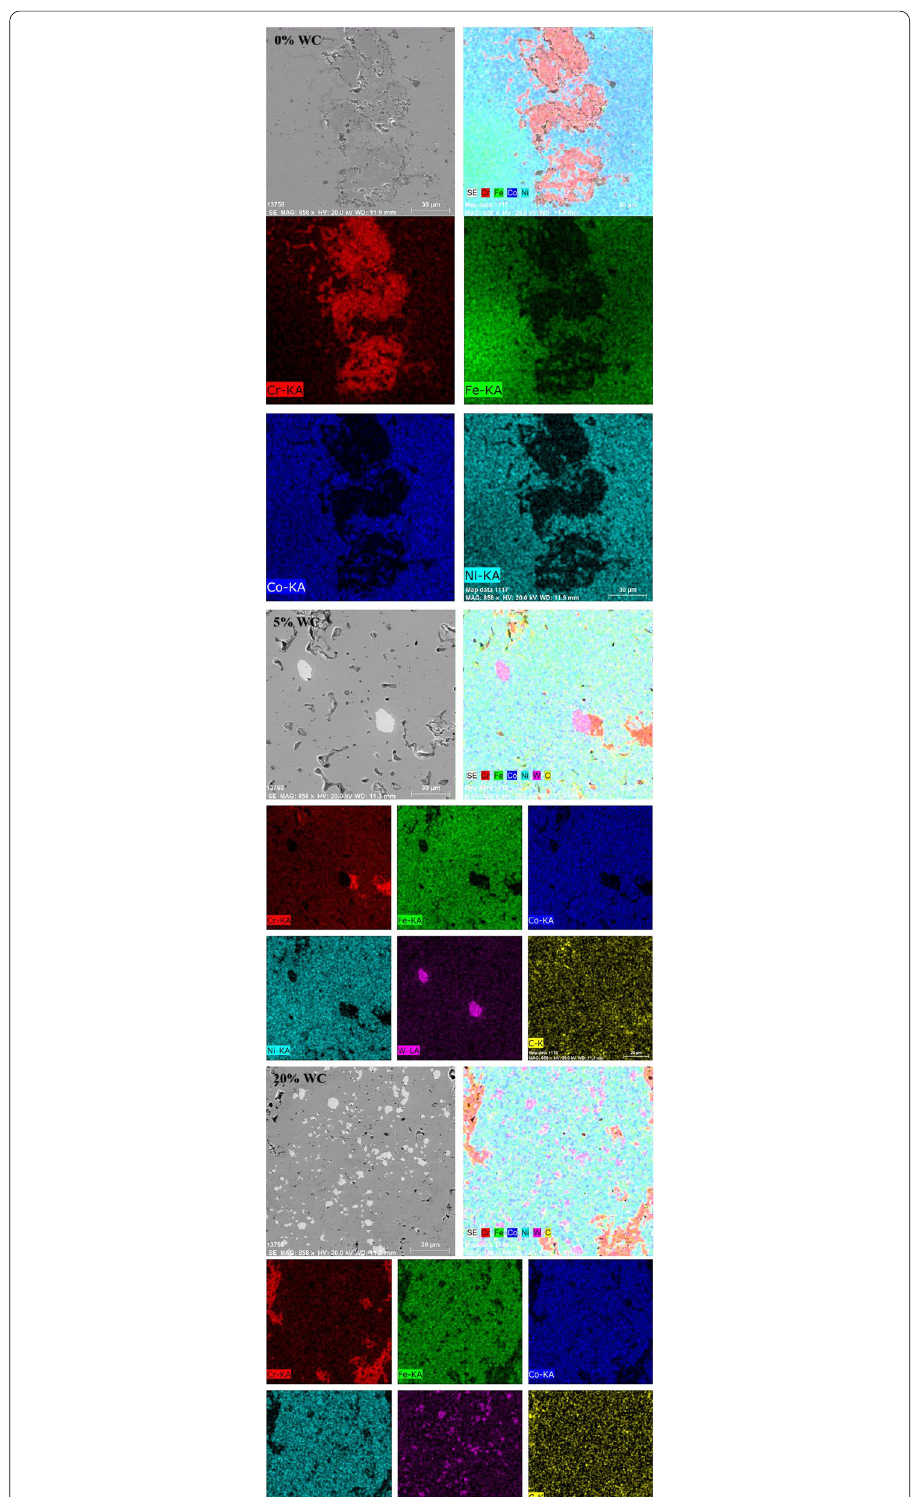
Fig. 7 SEM images of the elemental mapping of the (CrFeCoNi) 1-x (WC) x